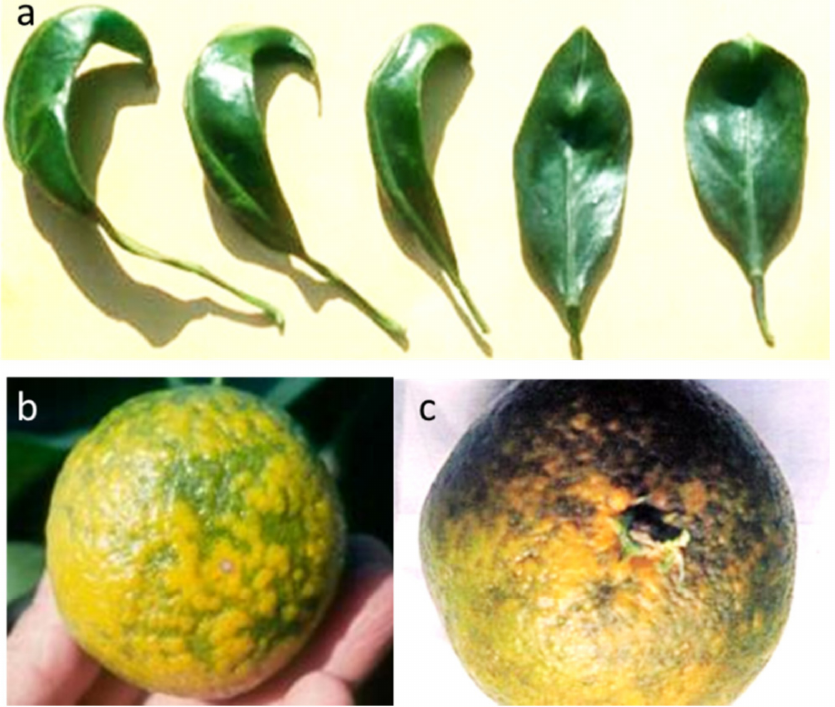
Figure 5. Boat-shaped leaves of Satsuma mandarin affected by satsuma dwarf virus ( a ), and the ring-shaped mosaic of the rind of the fruits before ( b ) and after the colored stage ( c ). Panels ( a , b ) retrieved from the Ecoport slideshow (http://citrus.ecoport.org/ accessed on 31 July 2021). Biological assays for citrus indicators are symptomatic only after eliminating the coinfected CTV isolate using the trifoliate orange as a filter [103]. Herbaceous hosts allow rapid diagnosis [104]. ELISA is useful for detecting SDV but unable to discriminate between the citrus mosaic virus, navel orange infectious mottling virus and Natsudaidai dwarf virus, which differ in amino acid composition from SDV by 25%